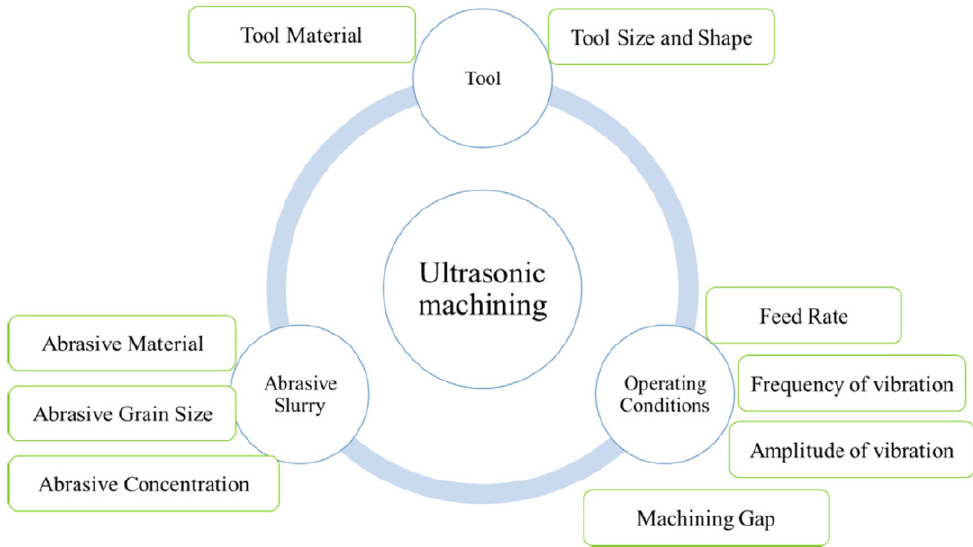
Figure 10. Parameters affecting the performance of ultrasonic machining (Reprinted with permission from Ref. [104]. 2022, copyright Elsevier Ltd.).